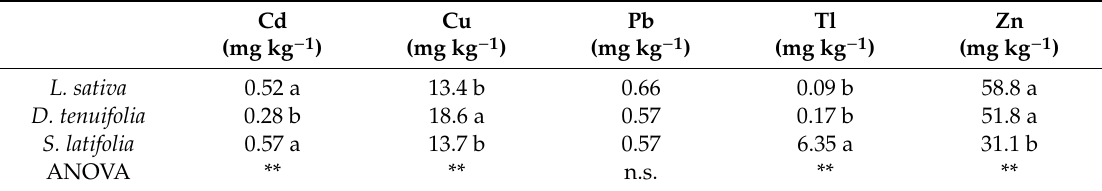
Table 4. Concentration of potentially toxic elements (PTEs) (mg kg − 1 d. w.) in shoots of L. sativa , D. tenuifolia and S. latifolia (three harvests weighted average).